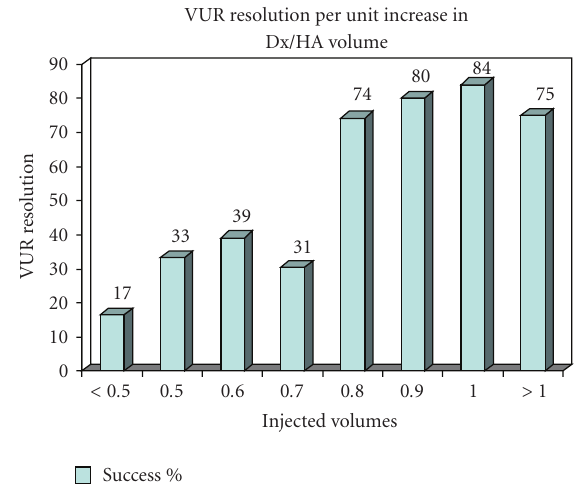
Figure 1: VUR correction rates for each 0.1 mL increment in injected Dx/HA volume.